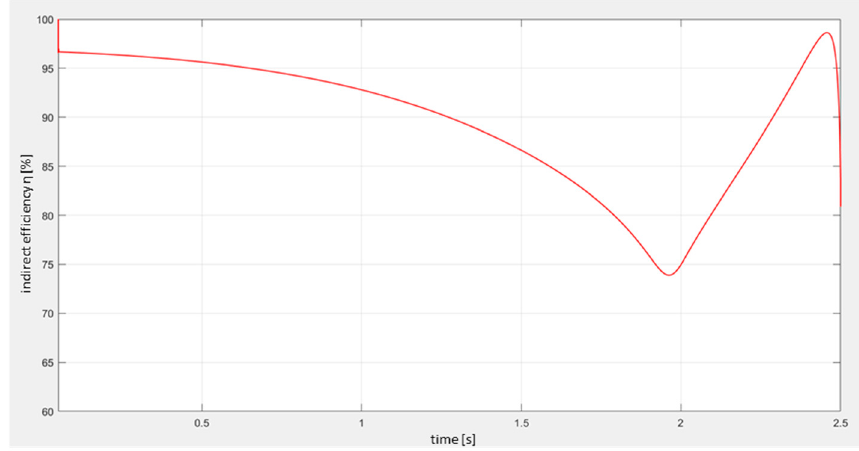
Figure 15. Indirect efficiency η as a function of time.